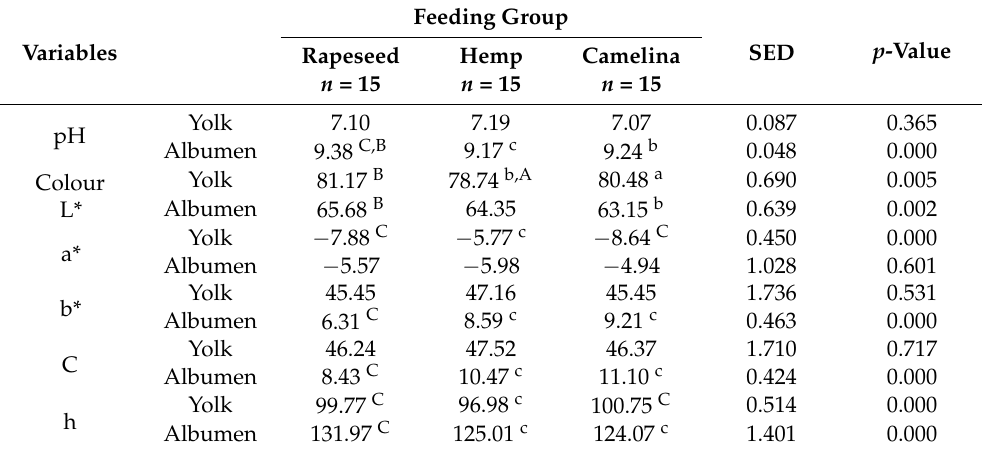
Table 4. Effects of diet on pH and colour of egg yolk and albumen in different quail